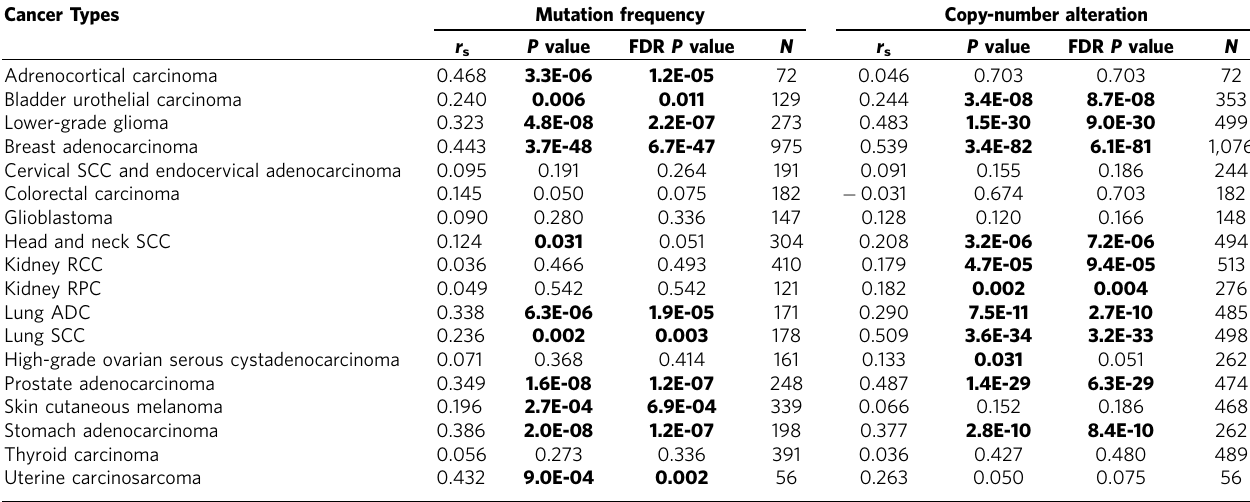
Table 1 | Correlation between tumour CES values and CNA and mutation frequencies in TCGA data sets. Cancer Types Mutation frequency